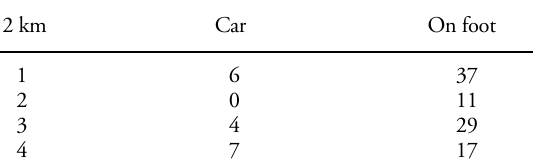
Table 3. Comparison of comparative counts of 4 × 2 km stretches of road recorded from a vehicle and on foot. Values are total road casualties observed over the same 20 sampling occasions for car and on foot.